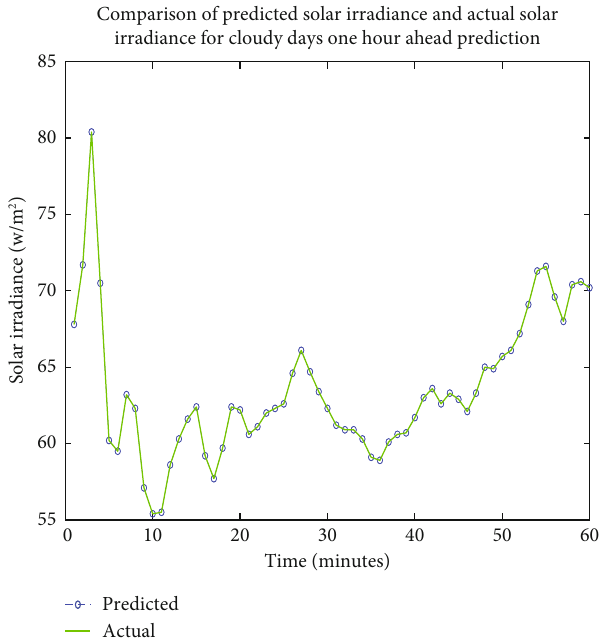
Figure 22: Comparison of predicted solar irradiance and actual solar irradiance for cloudy day one-hour-ahead prediction.